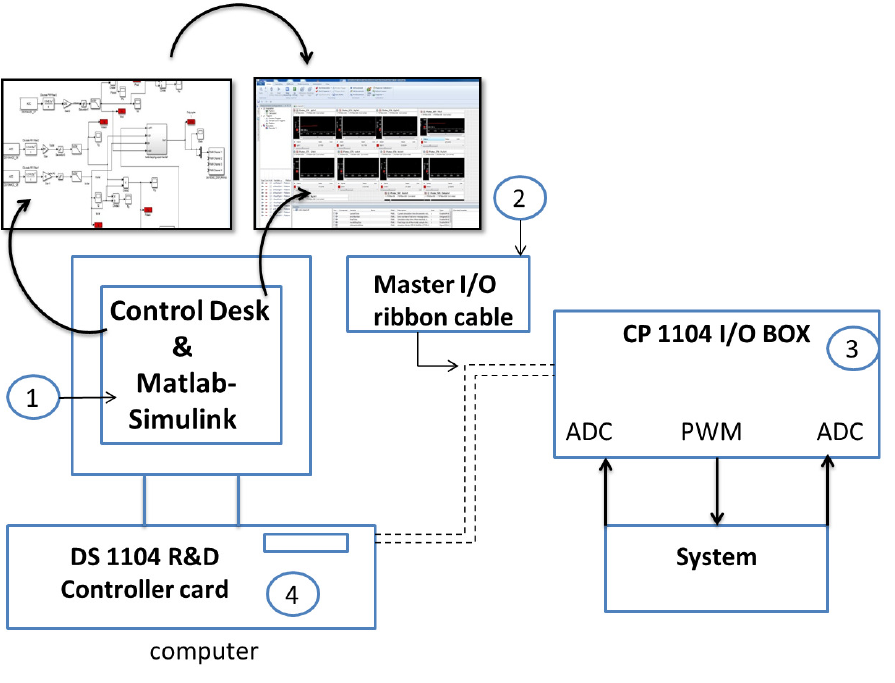
Figure 6. Components of the